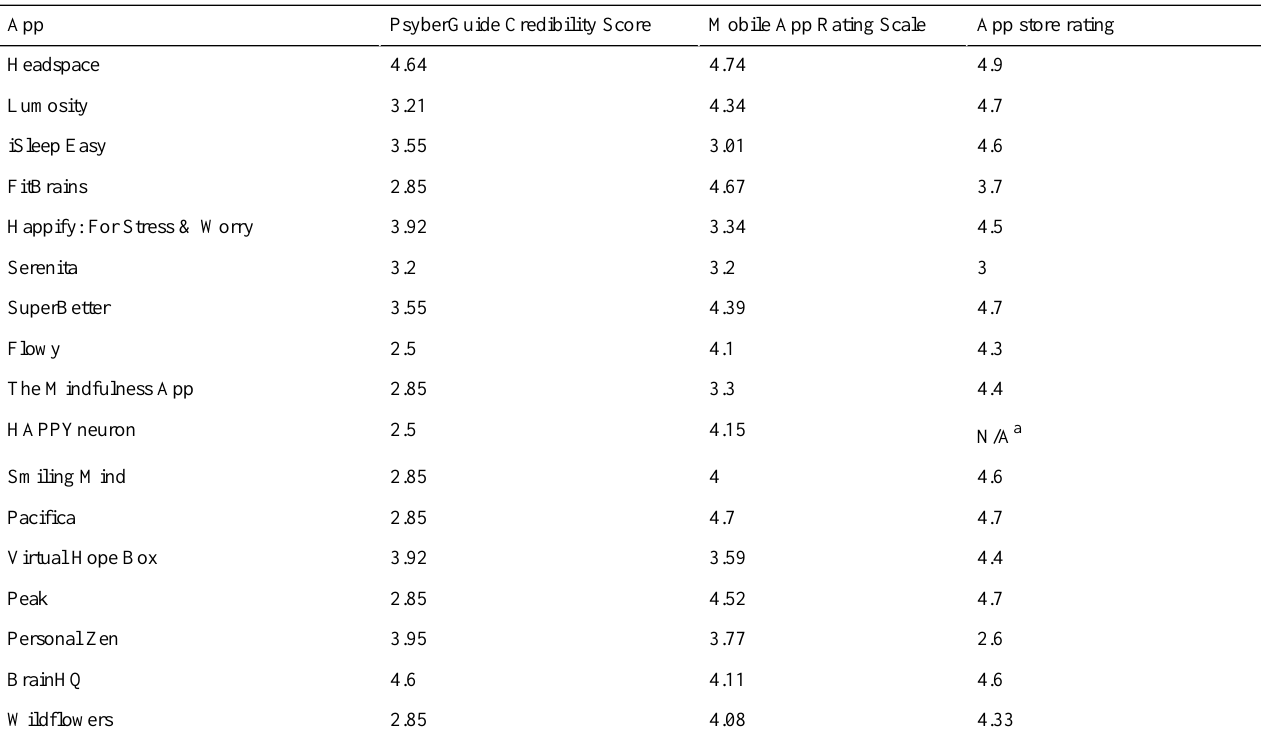
Table 5. Various metrics scoring each studied app (1-5